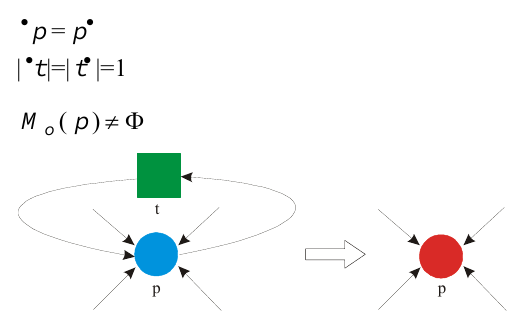
Fig.20. Cycle transition reduction rule